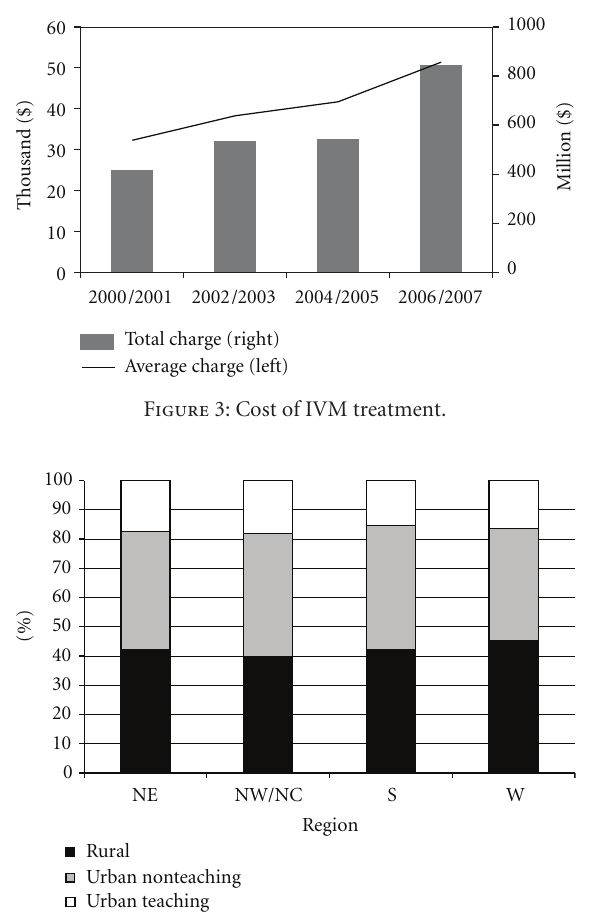
Figure 4: US geographic distribution of di ff erent types of hospitals in the NIS IVM sample.